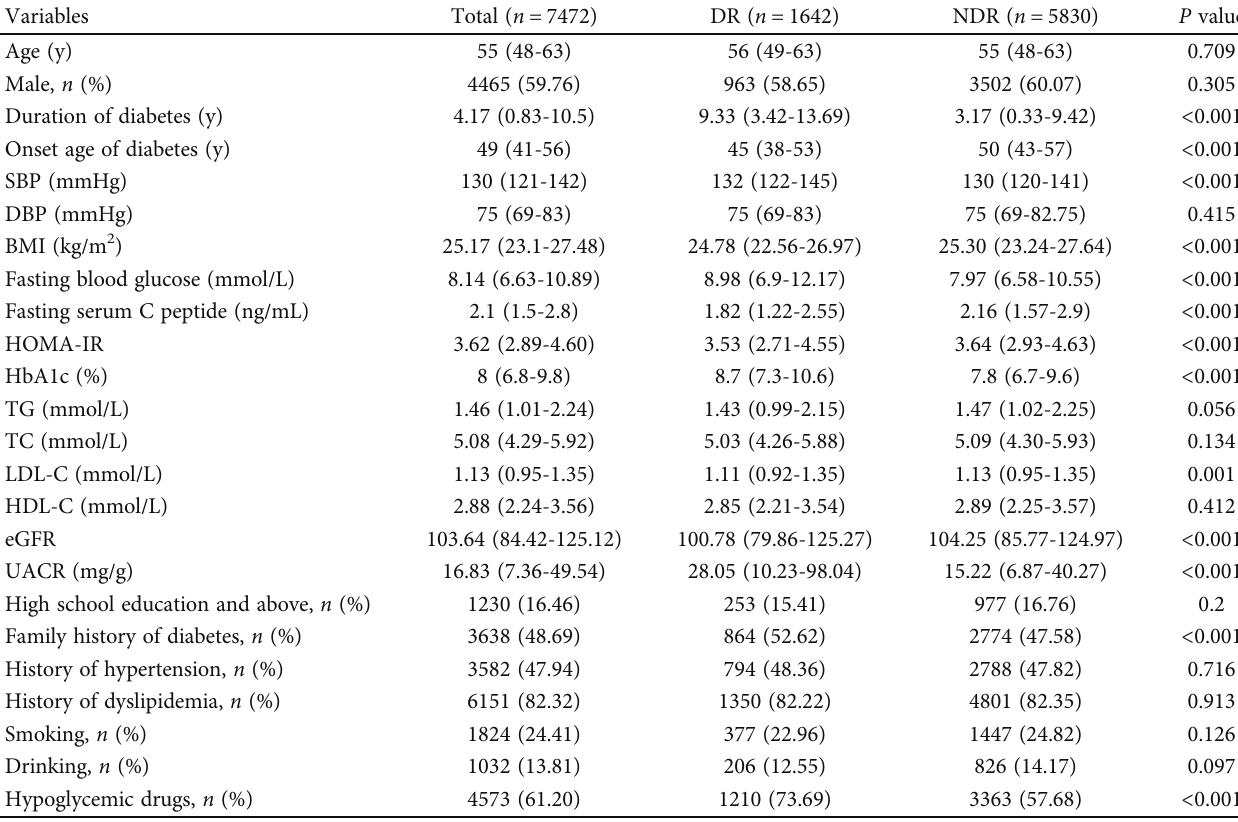
Table 1: Demographic and clinical parameters of study patients.